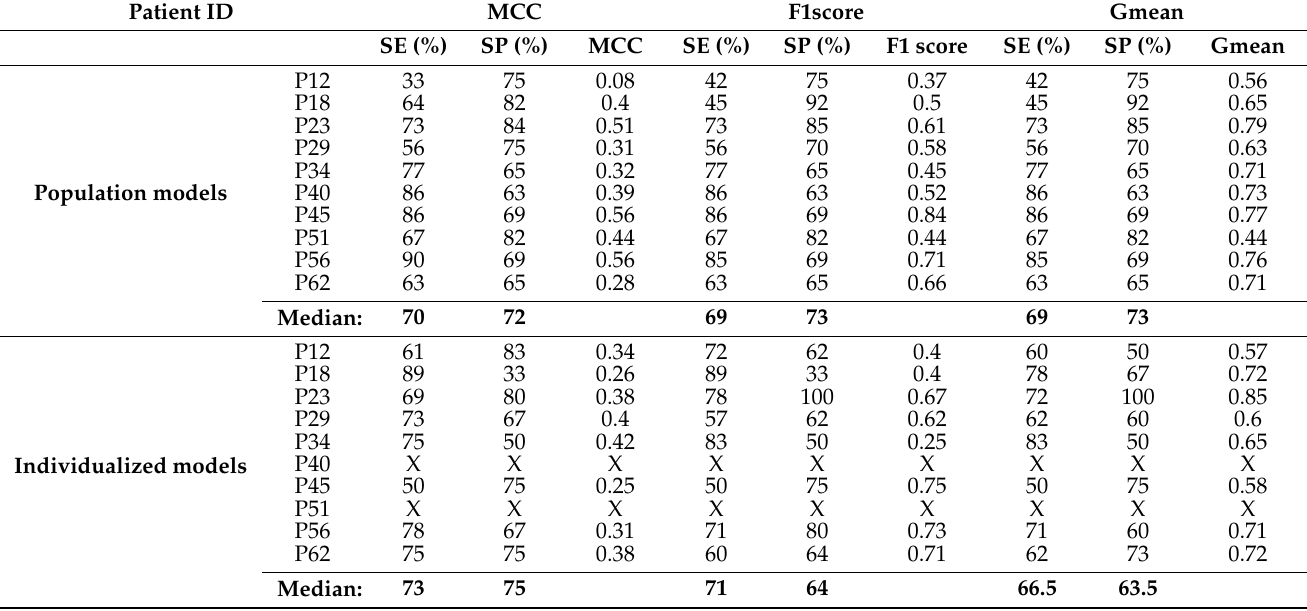
Table 3. Median sensitivity (SN) and specificity (SP) of the model using support vector machines (SVM), excluding physical activity measures. Three different performance metrics were evaluated: MCC, F1score and Gmean. Results are presented in percentage. Non-evaluated results are marked as X.